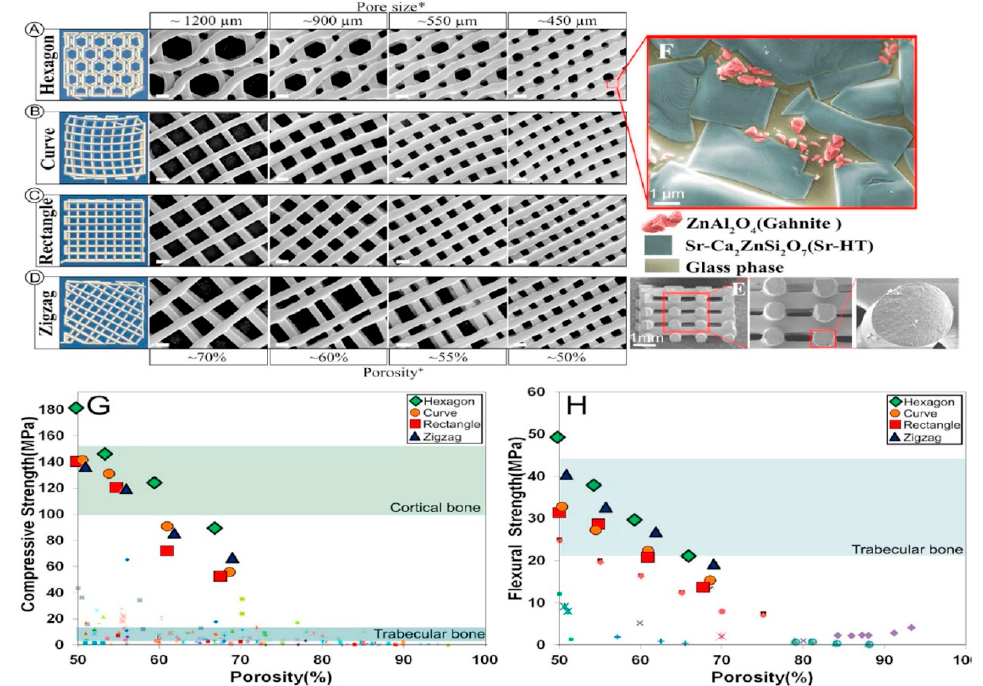
Figure 14. Models (left column) and SEM images of inspected sca ff olds (scale bars: 500 µ m unless stated otherwise); ( A ) Hexagonal; ( B ) curved; ( C ) rectangular and; ( D ) zigzag shape; ( E ) SEM images of fracture surface of a Sr-HT-Gahnite sca ff old fabricated by robocasting; ( F , G ) the microstructure of Sr-HT-Gahnite sca ff olds with distinct pore geometries vs porosity, and ( H ) flexural strength of Sr-HT-Gahnite sca ff olds with hydroxyapatite and BG sca ff olds [125]. Materials 2019 , 12 , x FOR PEER REVIEW 20 of 29